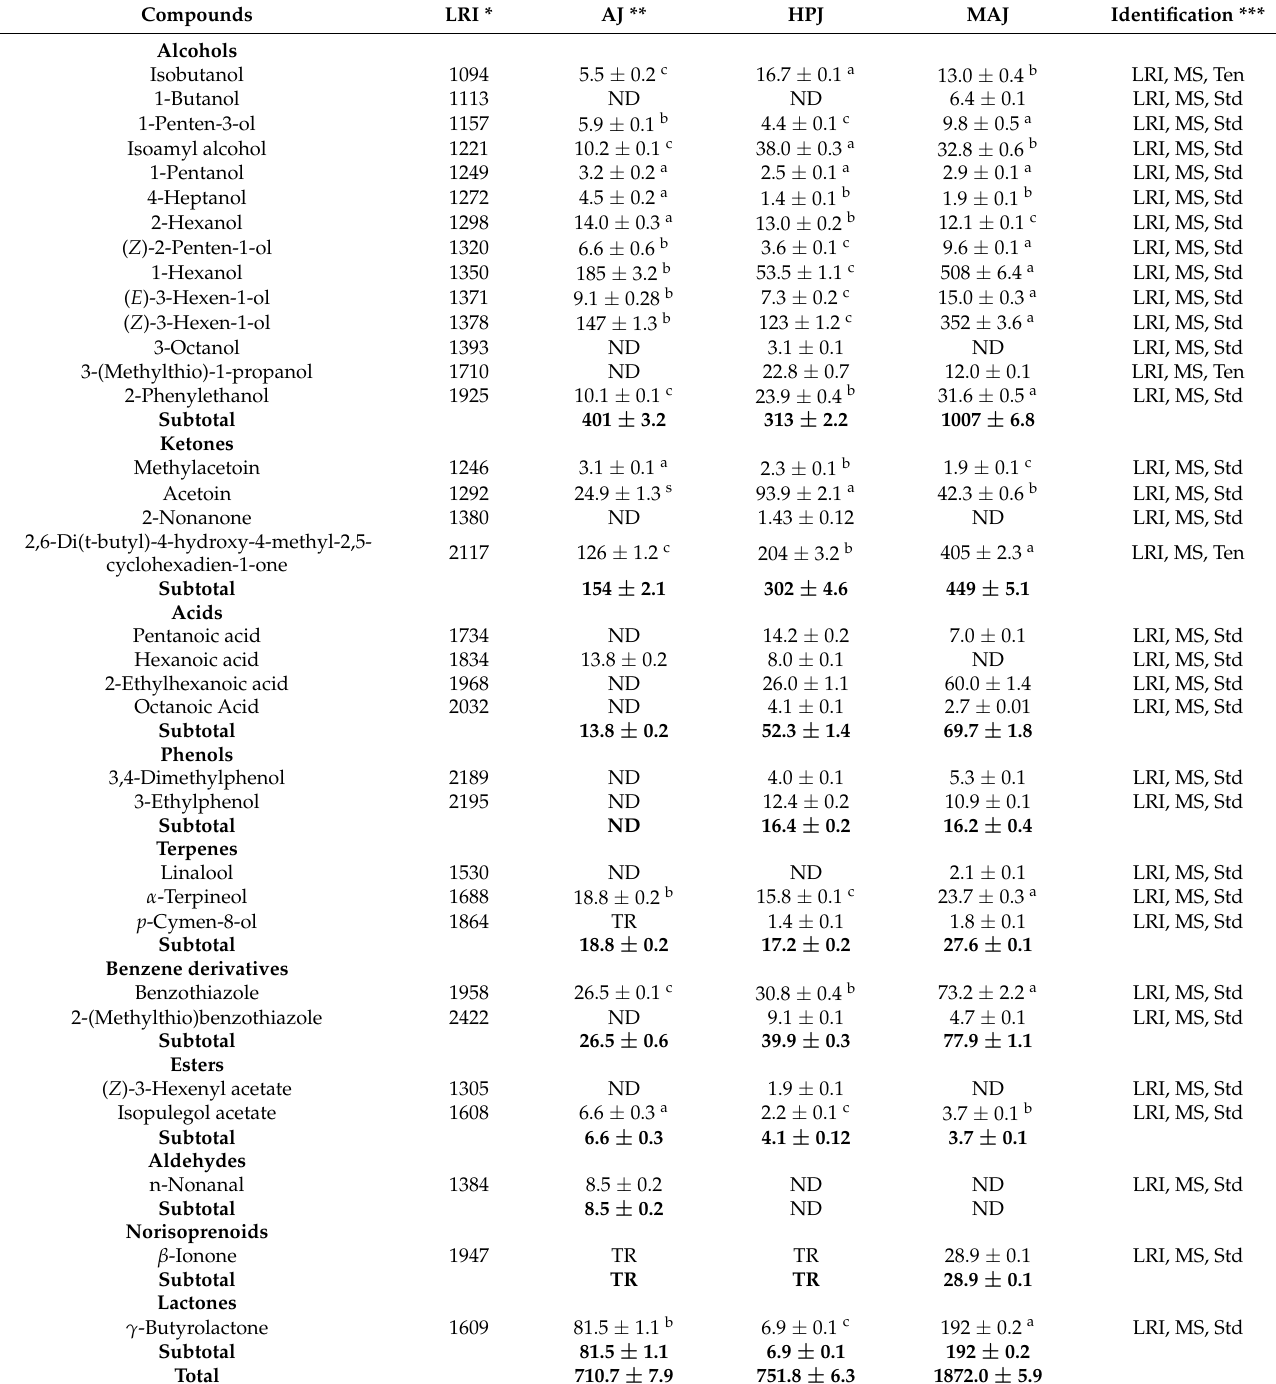
Table 4. Volatile compounds of pomegranate juice samples ( µ g L − 1